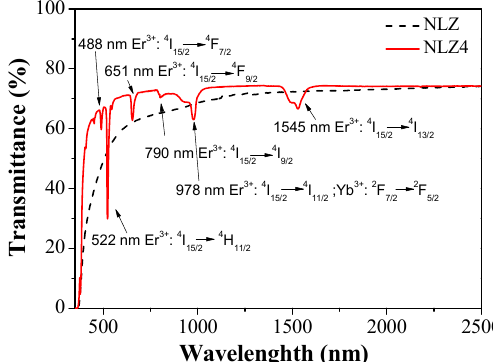
Fig. 2 Transmittance spectra of the undoped NLZ glass and doped NLZ4 sample.